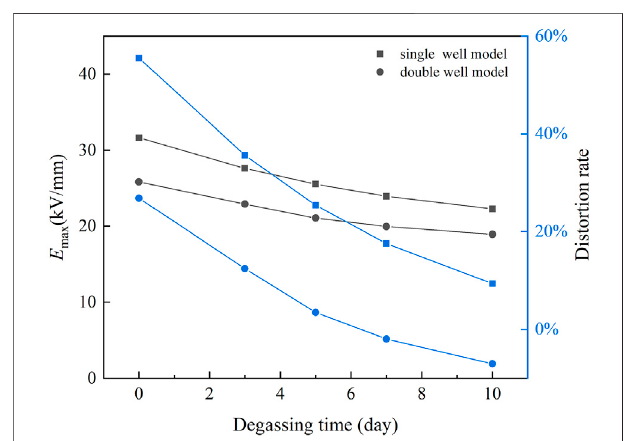
FIGURE 12 | E max and distortion rate of the electric fi eld in cable insulation during heat